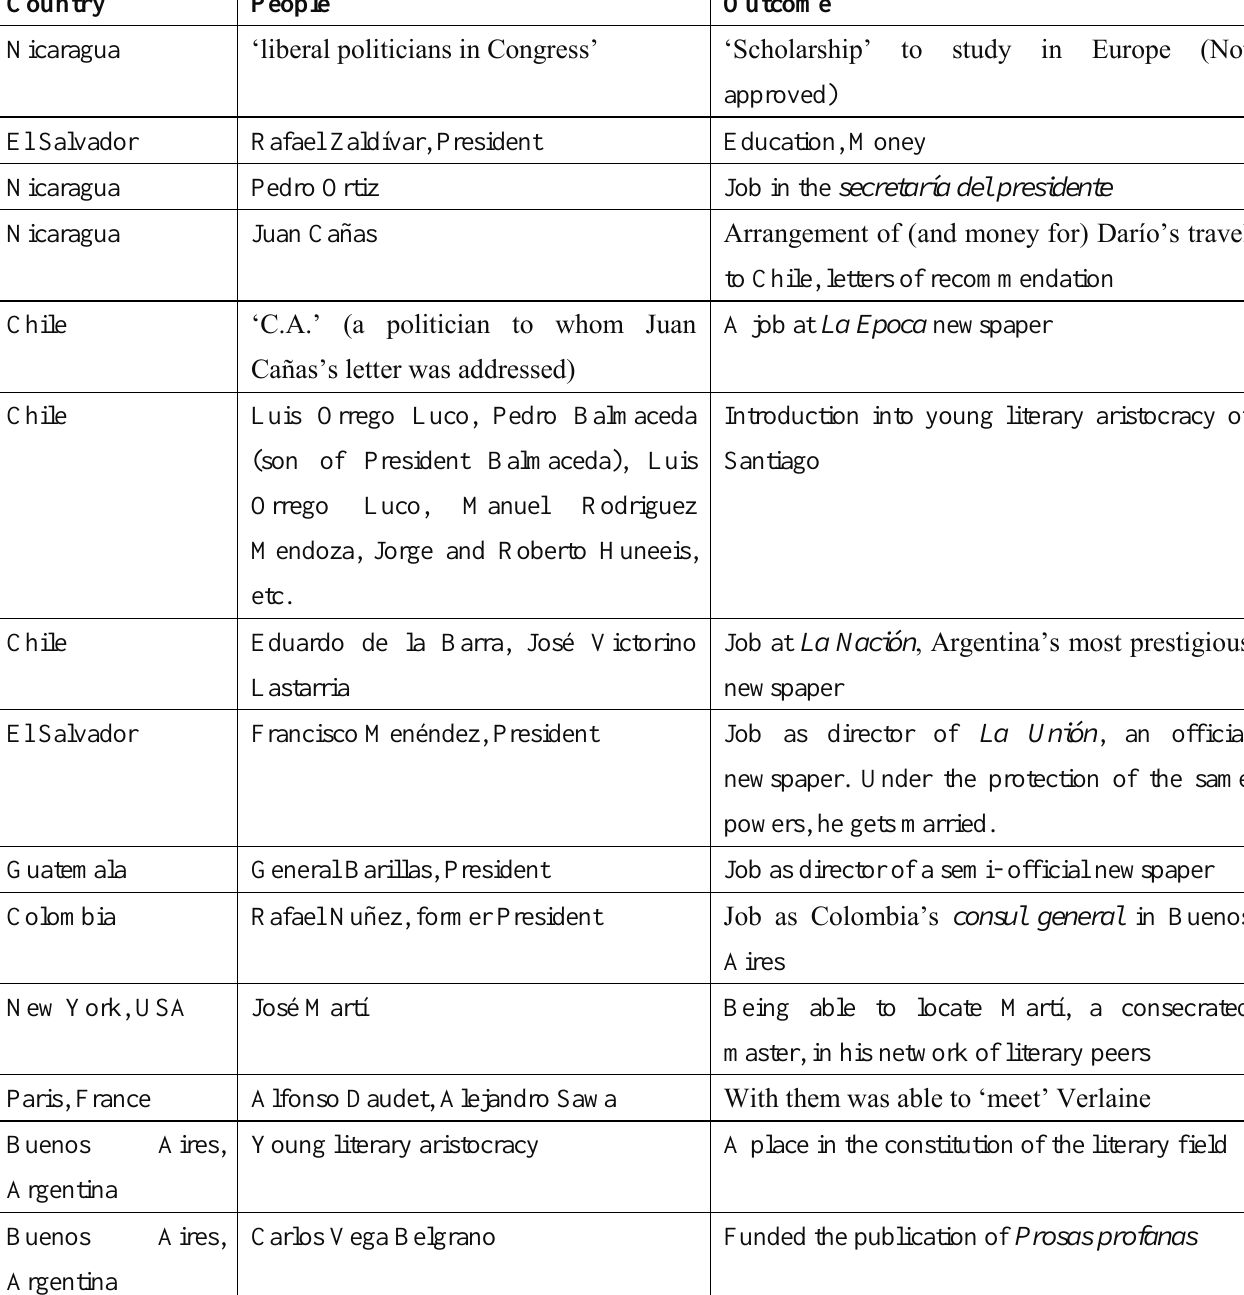
Table 1. Rubén Darío’s Accumulation of Symbolic